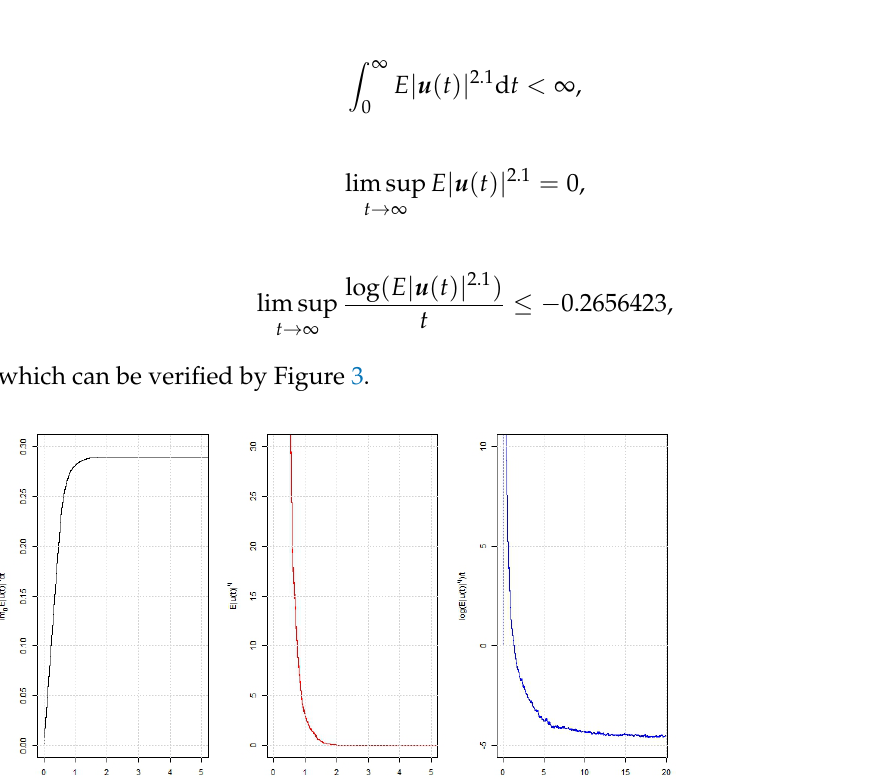
Figure 2. Stochastic trajectories of u ( t ) , log ( | u ( t ) | ) / t for system (23) with c = 0.